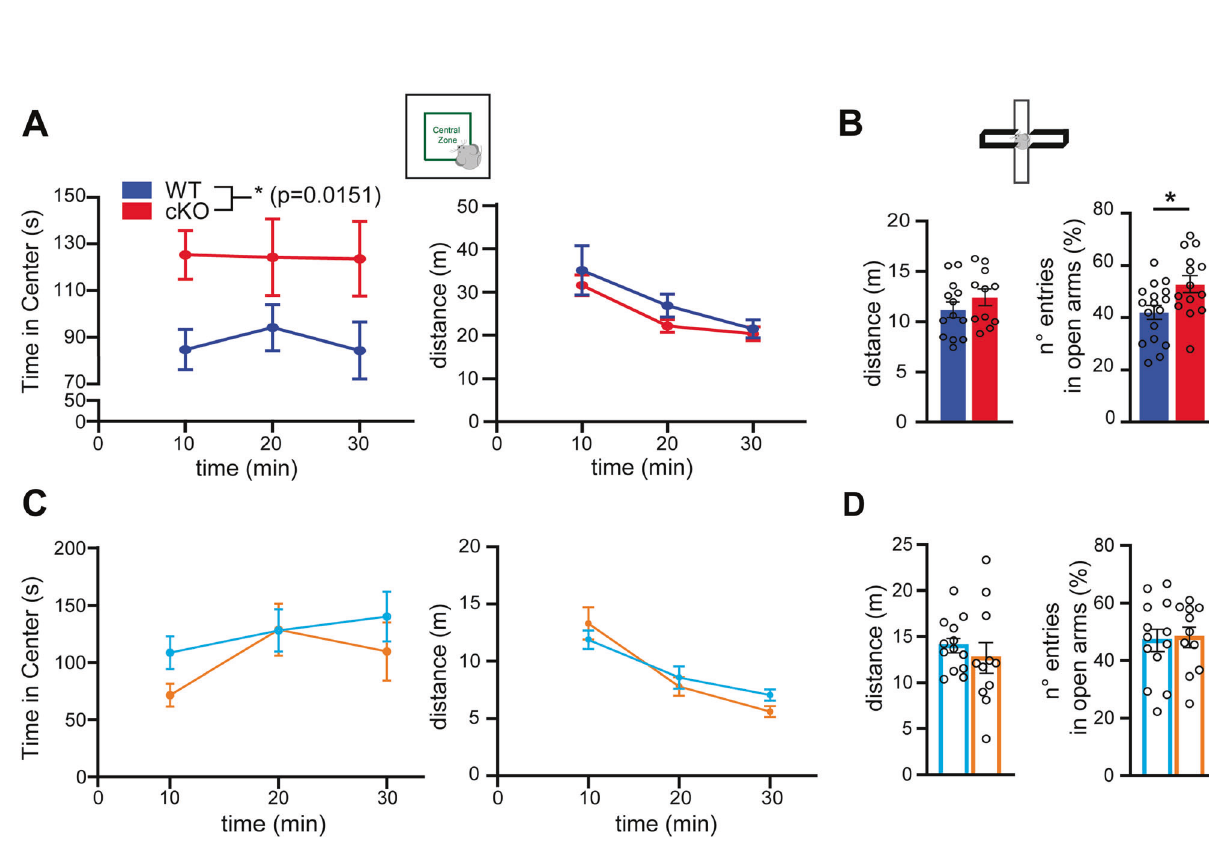
Fig. 4 Spatial memory is impaired in cKO females and associative memory is increased in Kidins220 lox/lox mice. A Morris Water Maze in cKO mice. Left: For the analysis, the maze was divided into four quadrants: north-west (NW), north-east (NE), south-east (SE), and south-west (SW), where the platform was located. The learning curve shows the time to reach the platform during the 5 training days, which was comparable in WT and cKO mice. Middle and right: the performance during the probe trial is represented for males and females separately. The performance of male mice was comparable among genotypes, while cKO females show impaired recollection of the platform location. Values are plotted as mean ± S.E.M. and individual values are represented with circles. The trial effect (not indicated in the graph) during the training phase was tested with a Repeated Measures ANOVA (RM-ANOVA) test [ F 4,80 = 15.88, * p < 0.05], indicating that both genotypes are ef fi ciently learning the task. The quadrant effect during the probe trial was tested with a two-way ANOVA test: males [ F 3,36 = 7.451, p > 0.05]; females [ F 3,24 = 28.95, * p < 0.05] with a signi fi cant genotype-quadrant interaction, indicated in the graph [ F 3,24 = 3,45, * p < 0.05, RM-ANOVA] and signi fi cant trial effect indicating different amount of time in each quadrant, not indicated in the graph for clarity. cKO (red) n = 10 (5 males); WT (blue) n = 1 (9 males). B Fear conditioning in cKO mice. Schematic representation of the different phases of the test (top) and corresponding quanti fi cation (bottom). The effectiveness of the conditioning is plotted as percentage time freezing. Fear conditioning trial . Three consecutive trials were performed (see Materials and methods section for details). The trial effect was tested with a RM-ANOVA test [ F 6, 210 = 57.89, **** p < 0.0001], indicating increased freezing as the trial progressed (not indicated in the graph). Both genotypes show comparable freezing behavior (genotype effect: [ F 1,35 = 2.81; p > 0.05 RM-ANOVA]). Context trial . This trial consisted of 5 min in the conditioning chamber in the absence of the cue and the shock. The results in this trial are represented separately for males and females. The genotype effect was tested with Student ’ s unpaired t -test; * p < 0.05. Novel context + cue . This trial consisted of 6 min in a new chamber during which mice were exposed to the same cue as in the fear conditioning trial. The trial effect was tested with a RM-ANOVA test [ F 2, 74 = 62.96, **** p < 0.0001]. No genotype effect was found during this trial: cKO mice show comparable conditioned behavior to WT mice [ F 1,37 = 0.112; p > 0.05 RM-ANOVA]. cKO n = 18 (6 males and 12 females), WT n = 20 (12 males and 8 females). C Fear conditioning in Kidins220 lox/lox mice. The experiment was performed and quanti fi ed as in B . Fear conditioning trial . The trial effect was tested with a RM-ANOVA test [ F 6, 138 = 19.53, **** p < 0.0001], indicating increased freezing as the trial progressed (not indicated in the graph). Both genotypes show comparable freezing behavior (genotype effect: F 1,23 = 2.194; p > 0.05 RM-ANOVA). Context trial . The genotype effect was tested with Student ’ s unpaired t -test; p > 0.05. Novel context + cue . The trial effect was tested with a RM-ANOVA test (genotype effect: F 2,42 = 4.1, * p < 0.05, indicated in the graph; Holm- Š ídák ’ s multiple comparisons test: ** p < 0.01 in ‘ cue ’ , *** p < 0.001 in ‘ post-cue ’ not indicated in the graph for clarity). Kidins220 lox/lox n = 11; + / + n = 14.